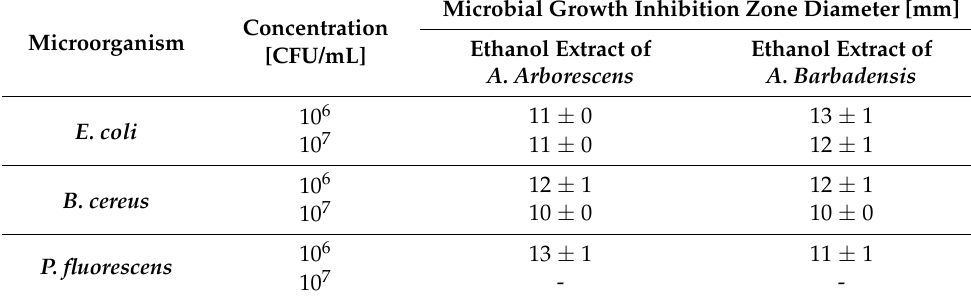
Table 4. Microbial growth inhibition zone diameter using ethanol extracts of A. arborescens and A. barbadensis as